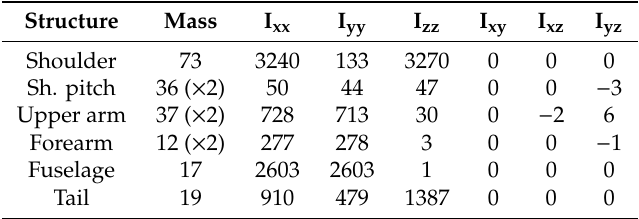
Figure 3. Rendered view of the structure of the dual arm. Table 3. Mass (in (g)) and moment of inertia (in (g·cm 2 ), relative to the center of mass) of the different structures of the winged aerial manipulation robot.